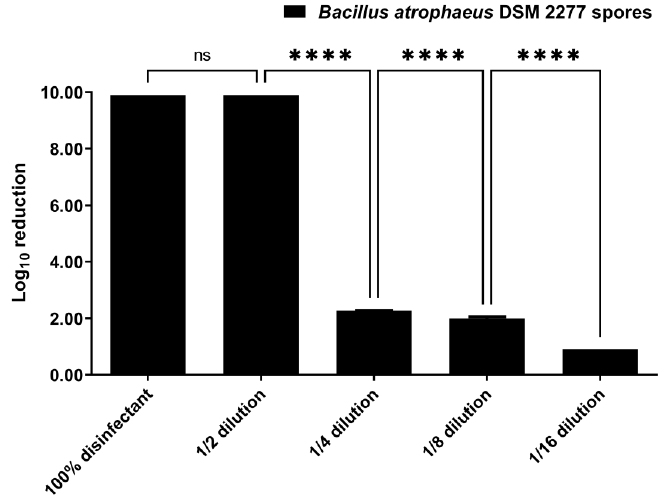
Figure 1. Log 10 reduction achieved in disinfection of Bacillus atrophaeus DSM 2277 spores by sus- pension test with different disinfectant concentrations. VIRCOV BAC 360 disinfectant was tested at